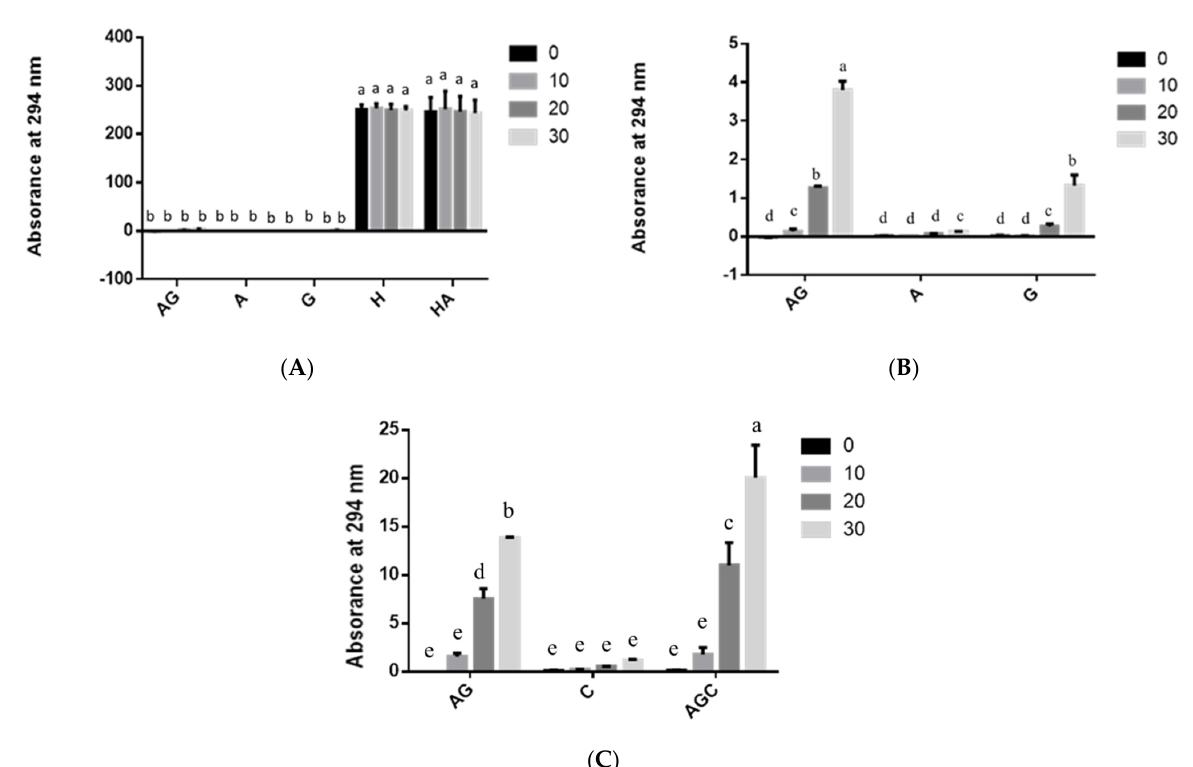
Figure 1. The UV absorbance at 294 nm of different groups in: ( A ) deionized water, ( B ) deionized water not including hydromethylfurfural groups, and ( C ) acetic acid at various time points during heating processing. AG: Asparagine + Glucose; A: asparagine; G: glucose; H: hydroxymethylfurfural; HA: hydroxymethylfurfural + asparagine; C: chitosan; AGC: asparagine + glucose + chitosan. Values are expressed as mean ± standard deviation (SD) ( n = 3). a–e Indicate significant differences between different groups ( p < 0.05).